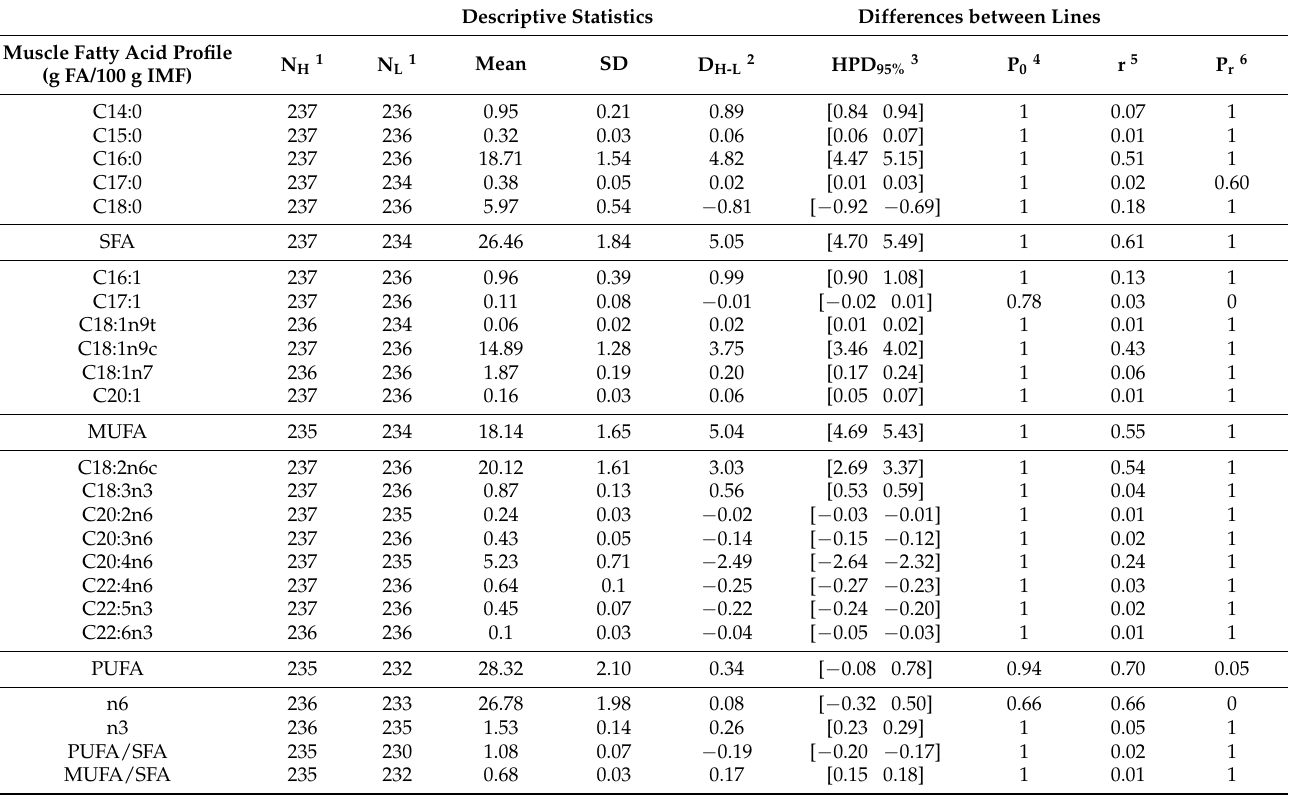
Table 2. Descriptive statistics and differences between lines of the meat fatty acid